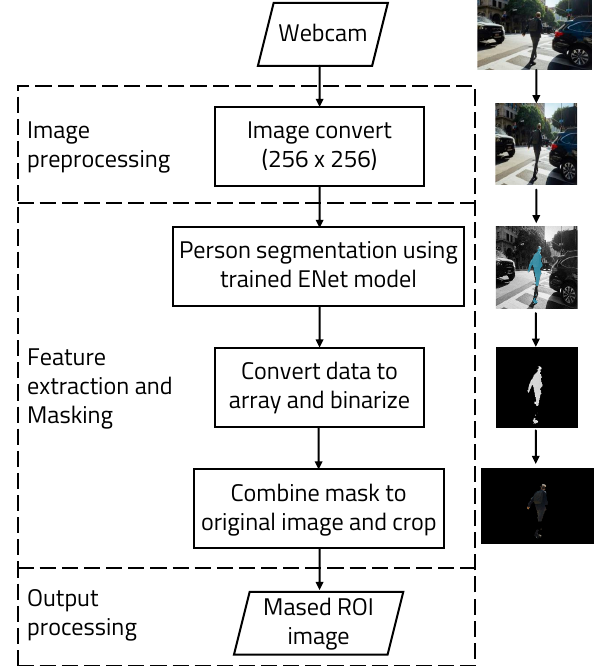
Figure 4. Algorithm used for semantic segmentation.